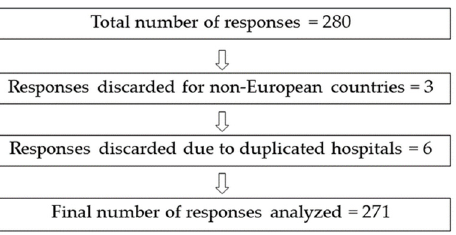
Figure 1. Graphic representation of discarded responses from the survey and total number of analyzable responses.